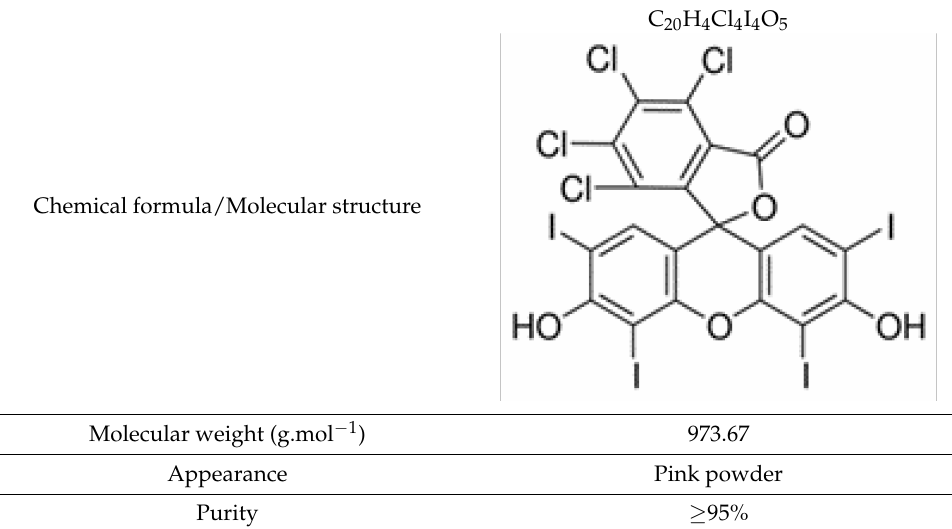
Table 2. Physicochemical properties of Rose Bengal lactone.